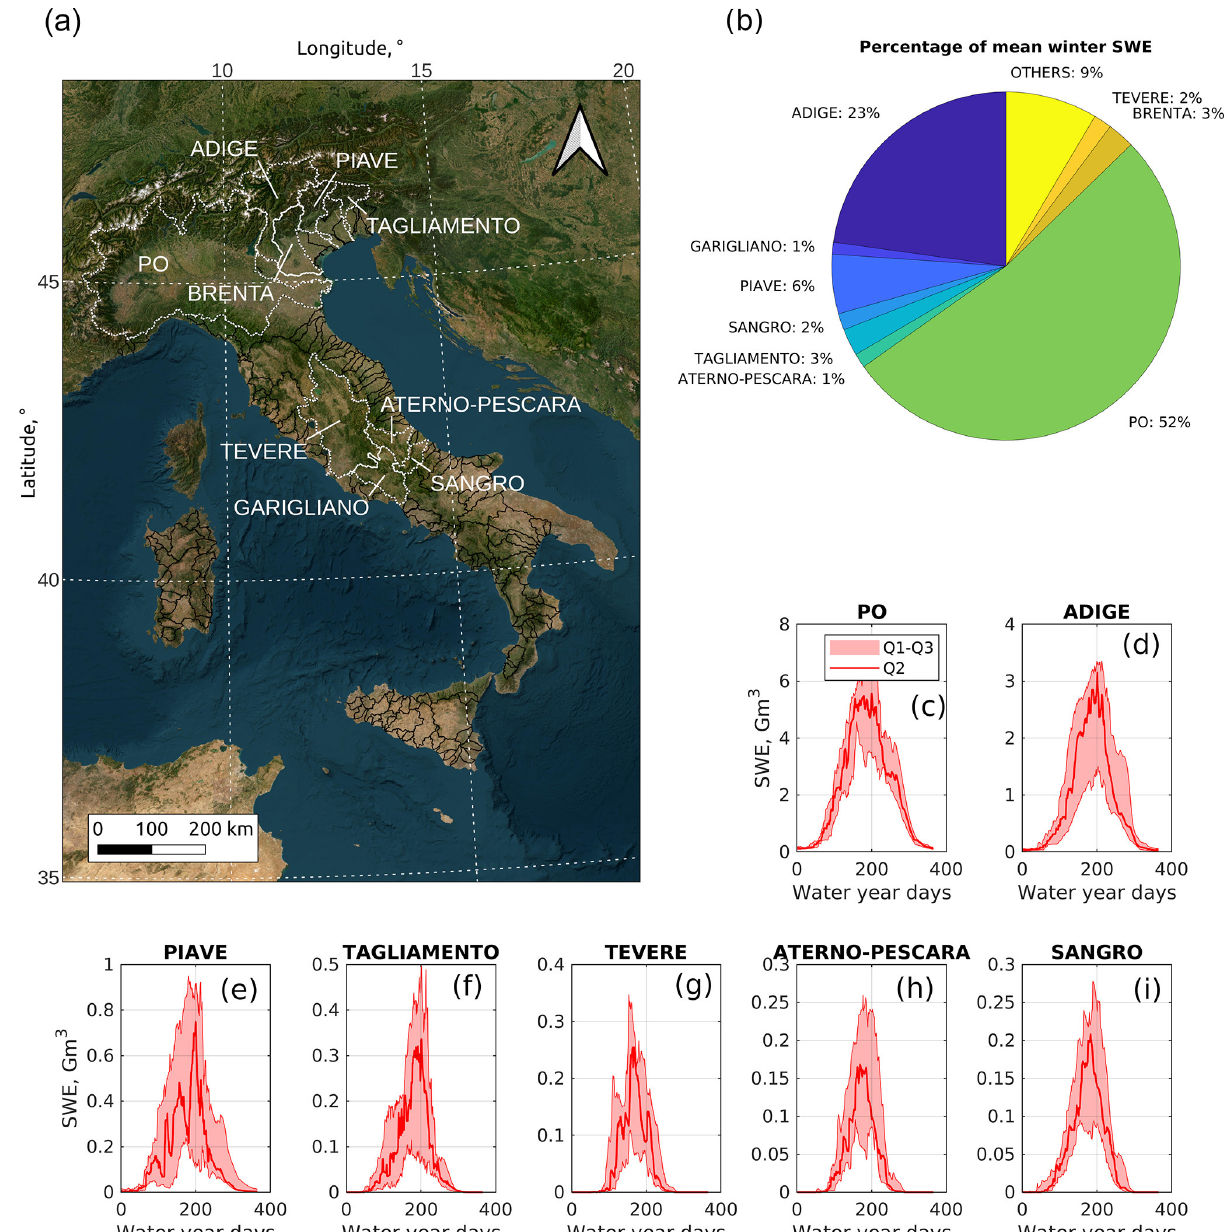
Figure 11. Example of use of IT-SNOW. (a, b) Percentage of mean winter SWE that is accumulated across the major Italian river basins (right) and location of these major basins across Italy (left). (c–i) Median and quartiles of daily basin-wide SWE across a selection of the most snow-dominated basins in Italy. Q2 is the median, and Q1 and Q3 are the first and third quartiles, respectively. The background map is from the Esri satellite theme. SWE is expressed here in the form of total volume of water stored in snow (Gm 3 ; see Sect.